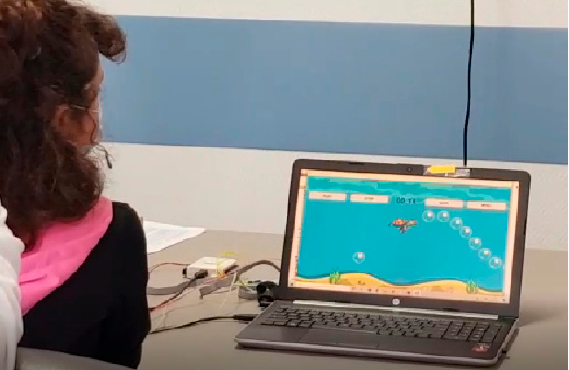
Figure 3 . VR game for force